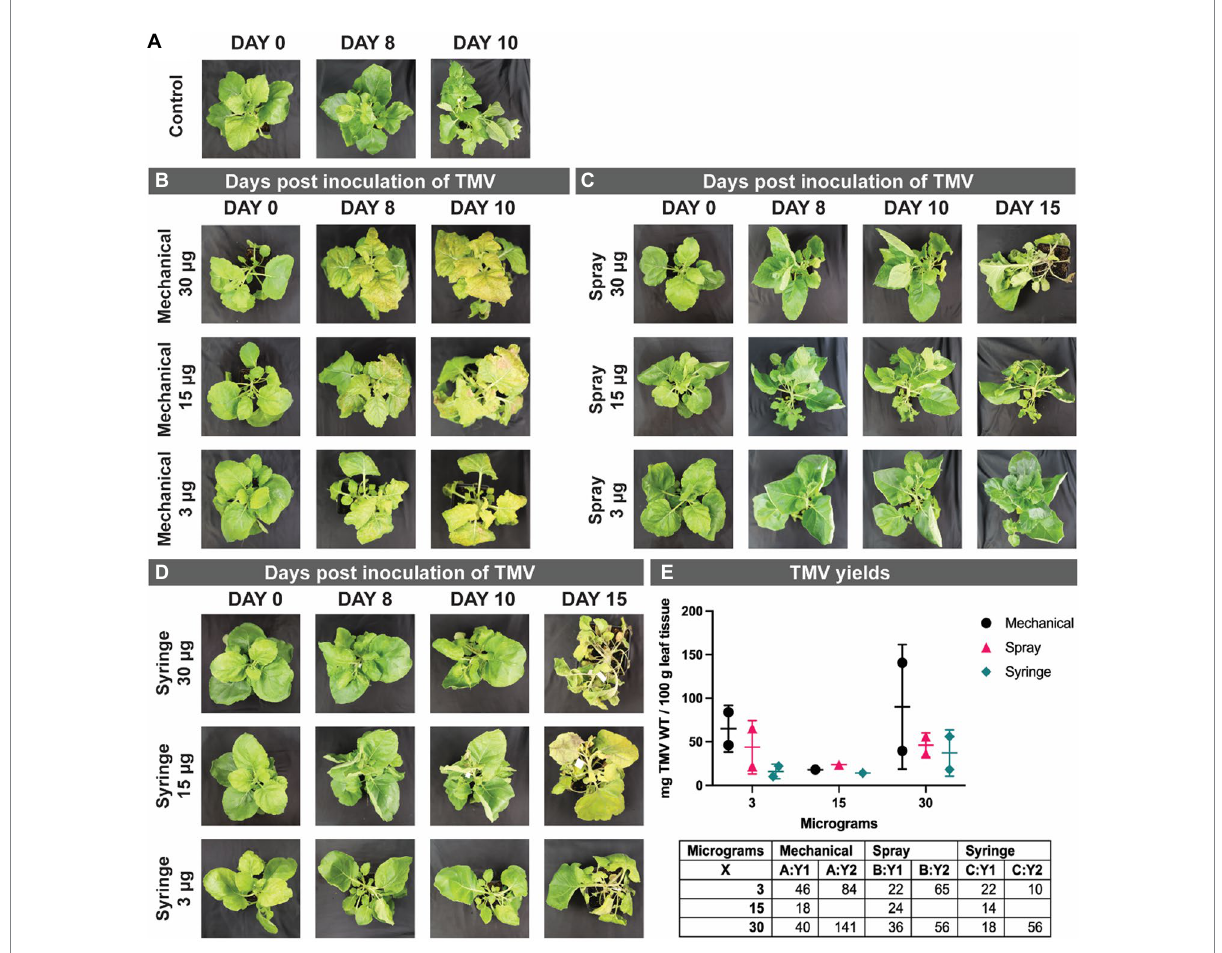
FIGURE 4 Representative photographs of N. benthamiana from day 0 to day 10–15, control non-infected plants (A) , and TMV days post inoculation (dpi) by mechanical (B) , spray (C) , and syringe (D) method using 3, 15, and 30 μ g of TMV. Graphed yields, and a table of the values for the TMV yields obtained (E) . The experiments were done in duplicate using 10 plants per treatment. Additional control plants are shown in the Supplementary Information, Supplementary Figure